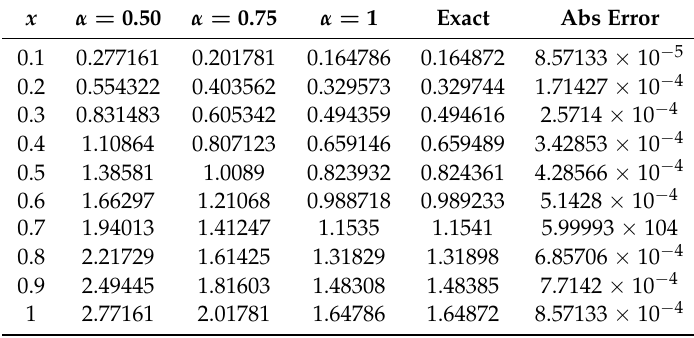
Table 13. Third order approximate results for different values of α at t = 0.50 of Example 3.